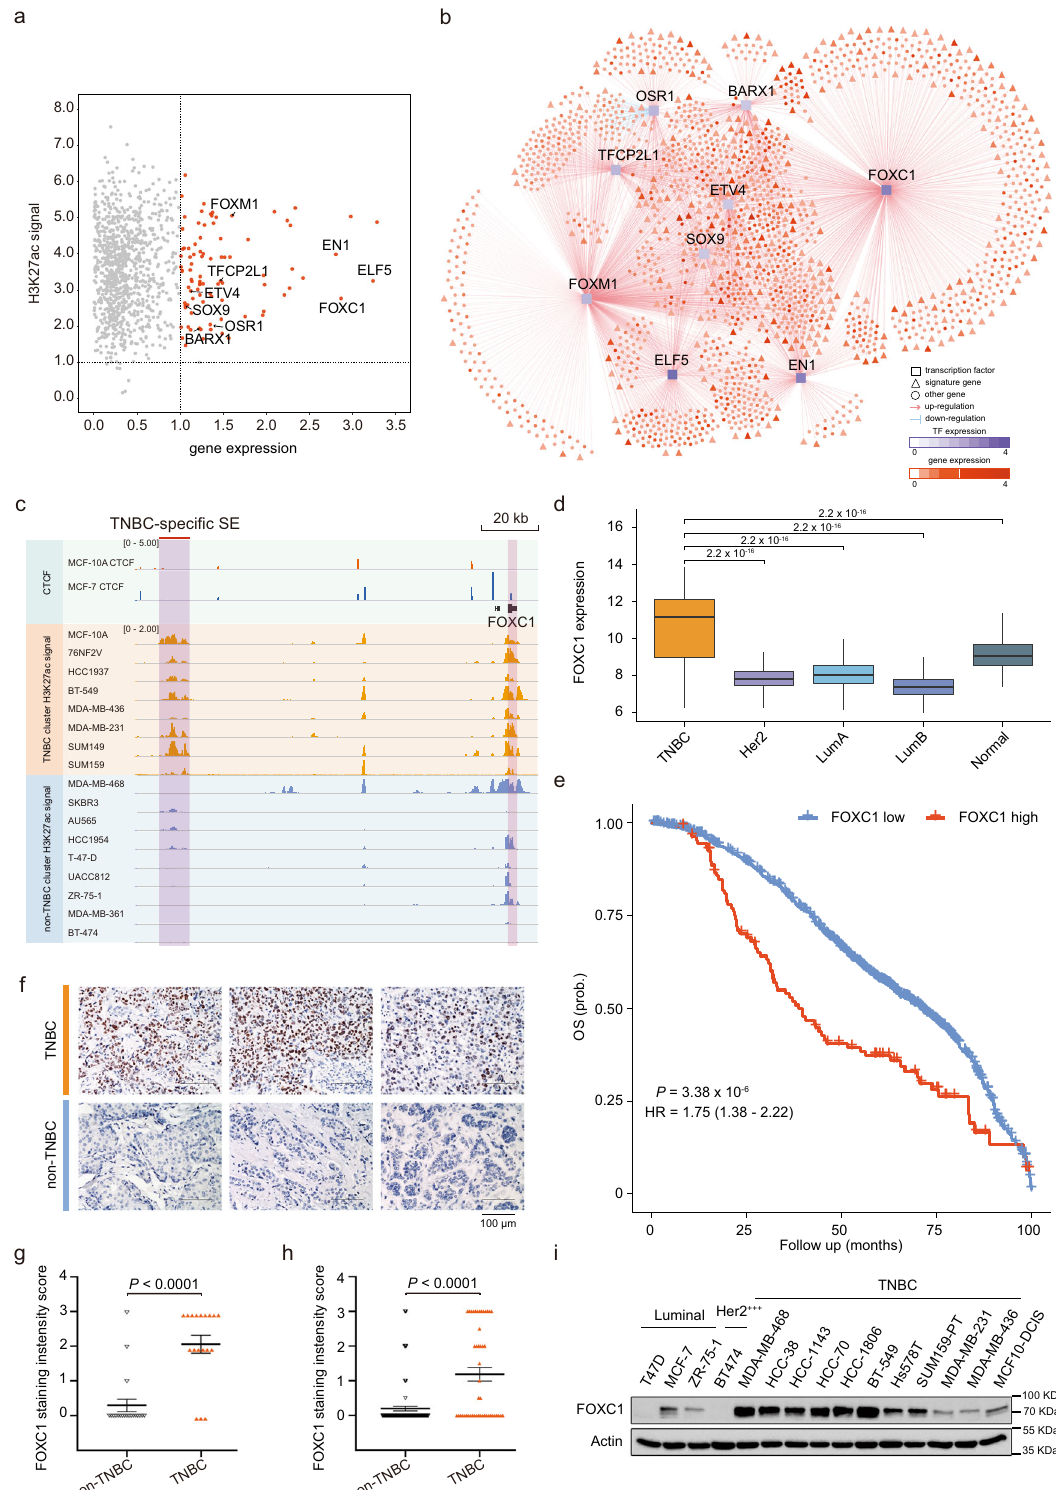
family of TFs which is characterized by a distinct DNA-binding forkhead domain, is associated with an activated TNBC-speci fi c SE nearby (Fig. 3c). It was noted that a strong CTCF peak was observed right upstream of the promoter region of FOXC1 in non-TNBC-subtype cell line MCF-7 but not in TN, immortalized breast line MCF-10A, suggesting the potential insulator function in blocking the transcription of FOXC1 in non-TNBC. These spheroid growth and invasion . The clinical signi fi cance of NATURE COMMUNICATIONS| (2021) 12:2242